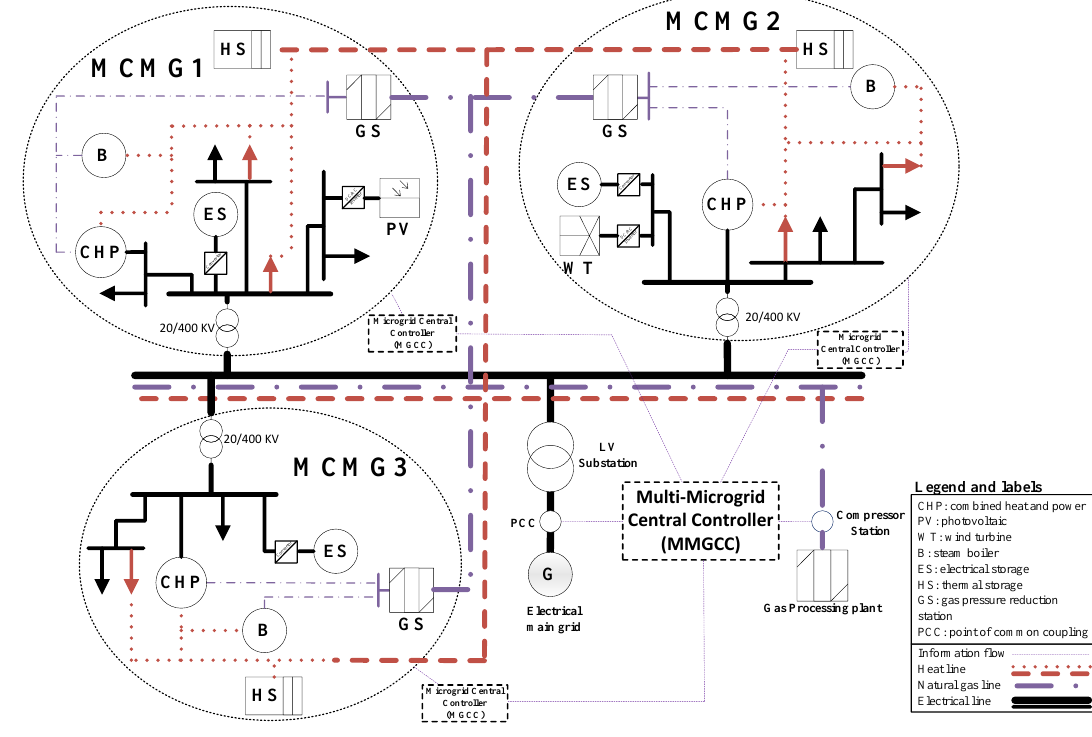
Figure 1. Structure of MCNMG.